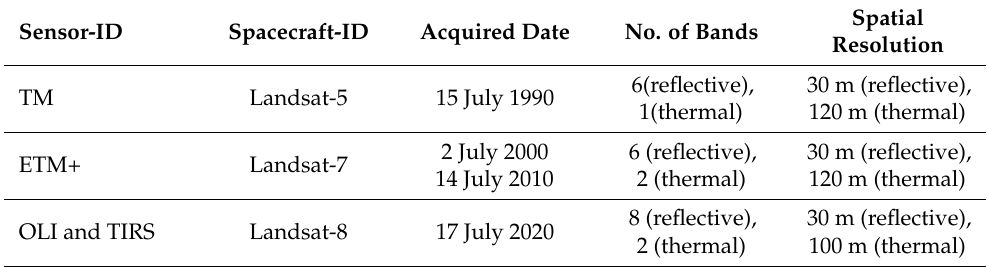
Table 1. Landsat image